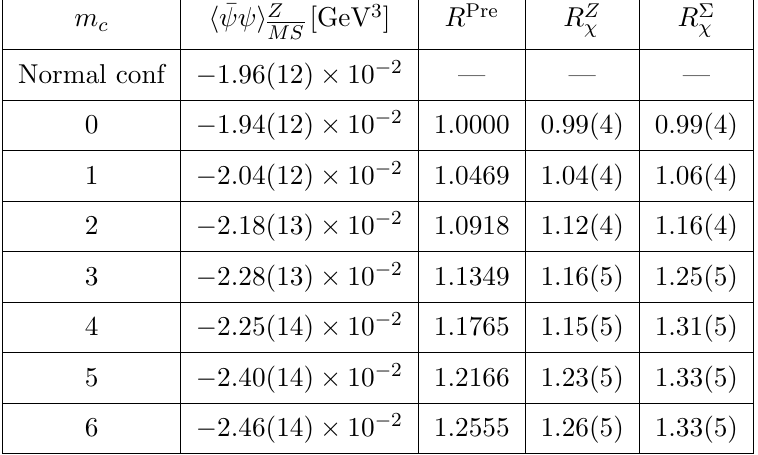
and the ratios of the prediction R Pre and MS